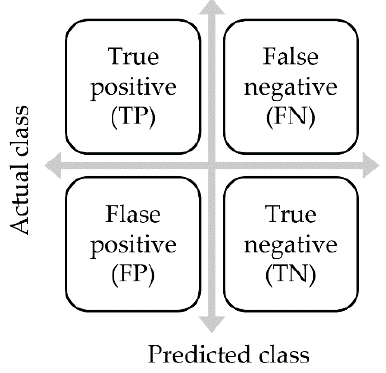
Figure 7. Schematic showing a confusion matrix.